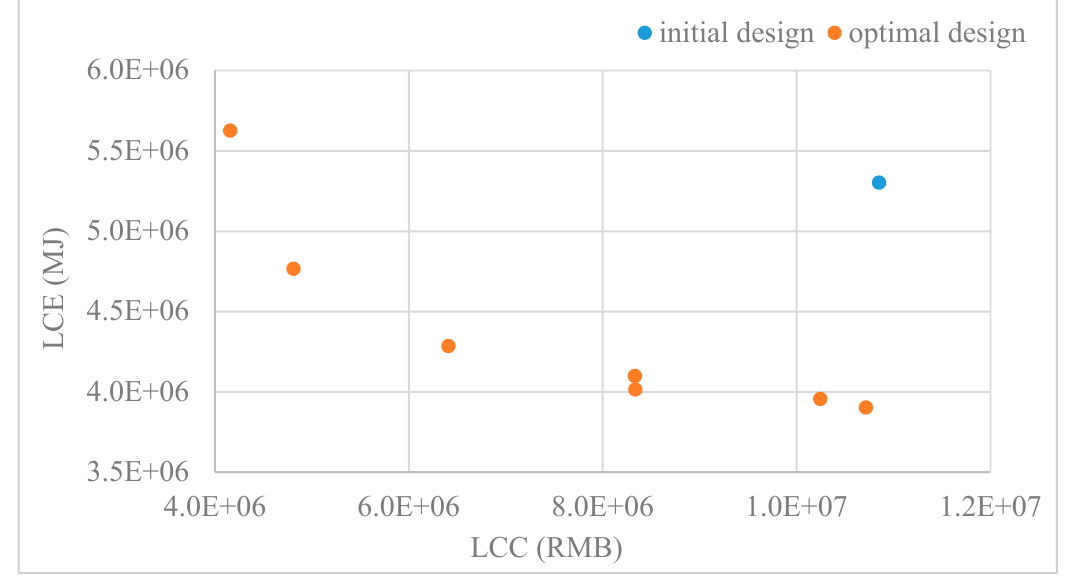
Figure 3. Pareto frontier of case study. Table 3. Information about optimal designs.